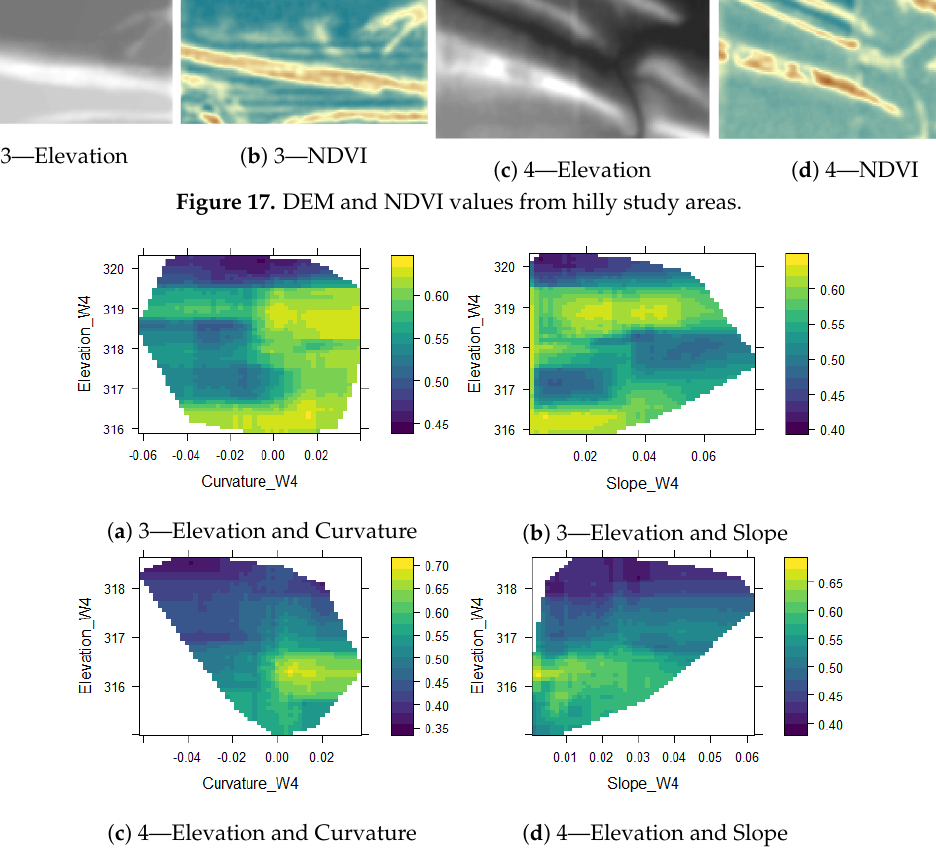
Figure 18. PDPs corresponding to hilly study areas w.r.t.